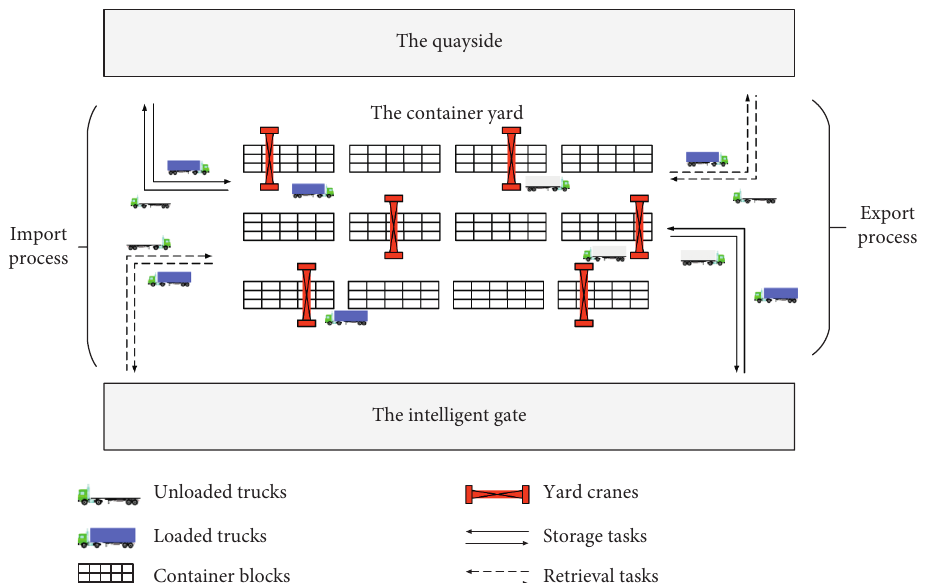
Figure 1: Configuration of the container